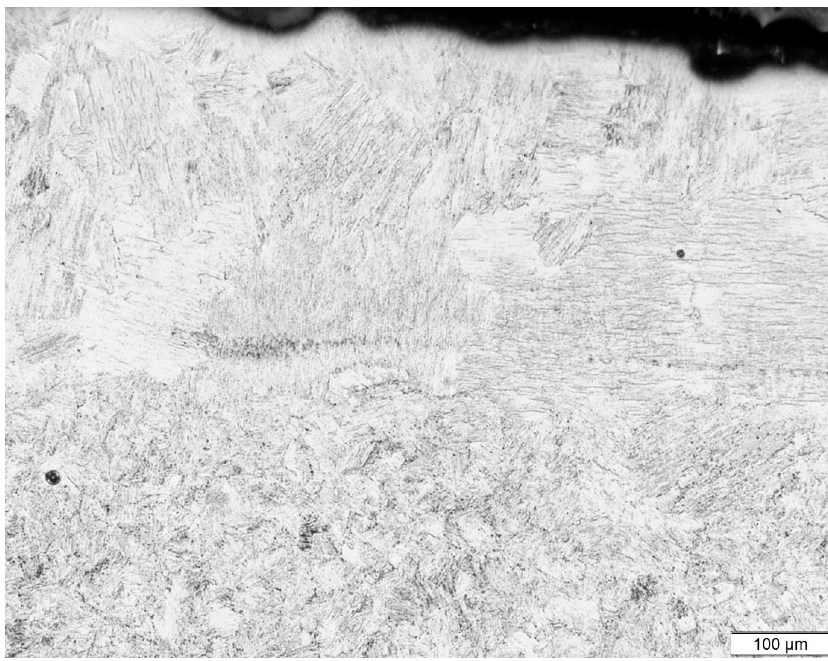
Figure 7. Coarse microstructure in the last layer(s) of the high energy sample. Table 3. Scanning electron microscopy–Energy dispersive X-ray spectroscopy ( SEM–EDS) analysis at the center of γ -TiAl samples produced using low and high-energy inputs.